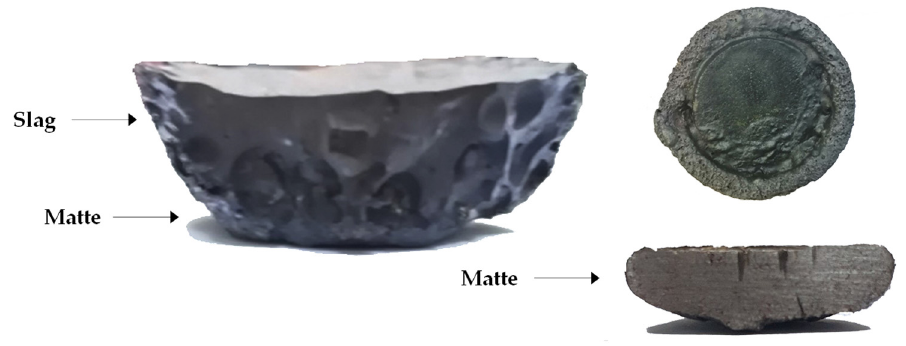
Figure 20. Products of 86/14_S smelting. Table 10. Results of smelting tests, with jarosite-PbAg sludge sulfidized with the addition of sul- fur and carbon.